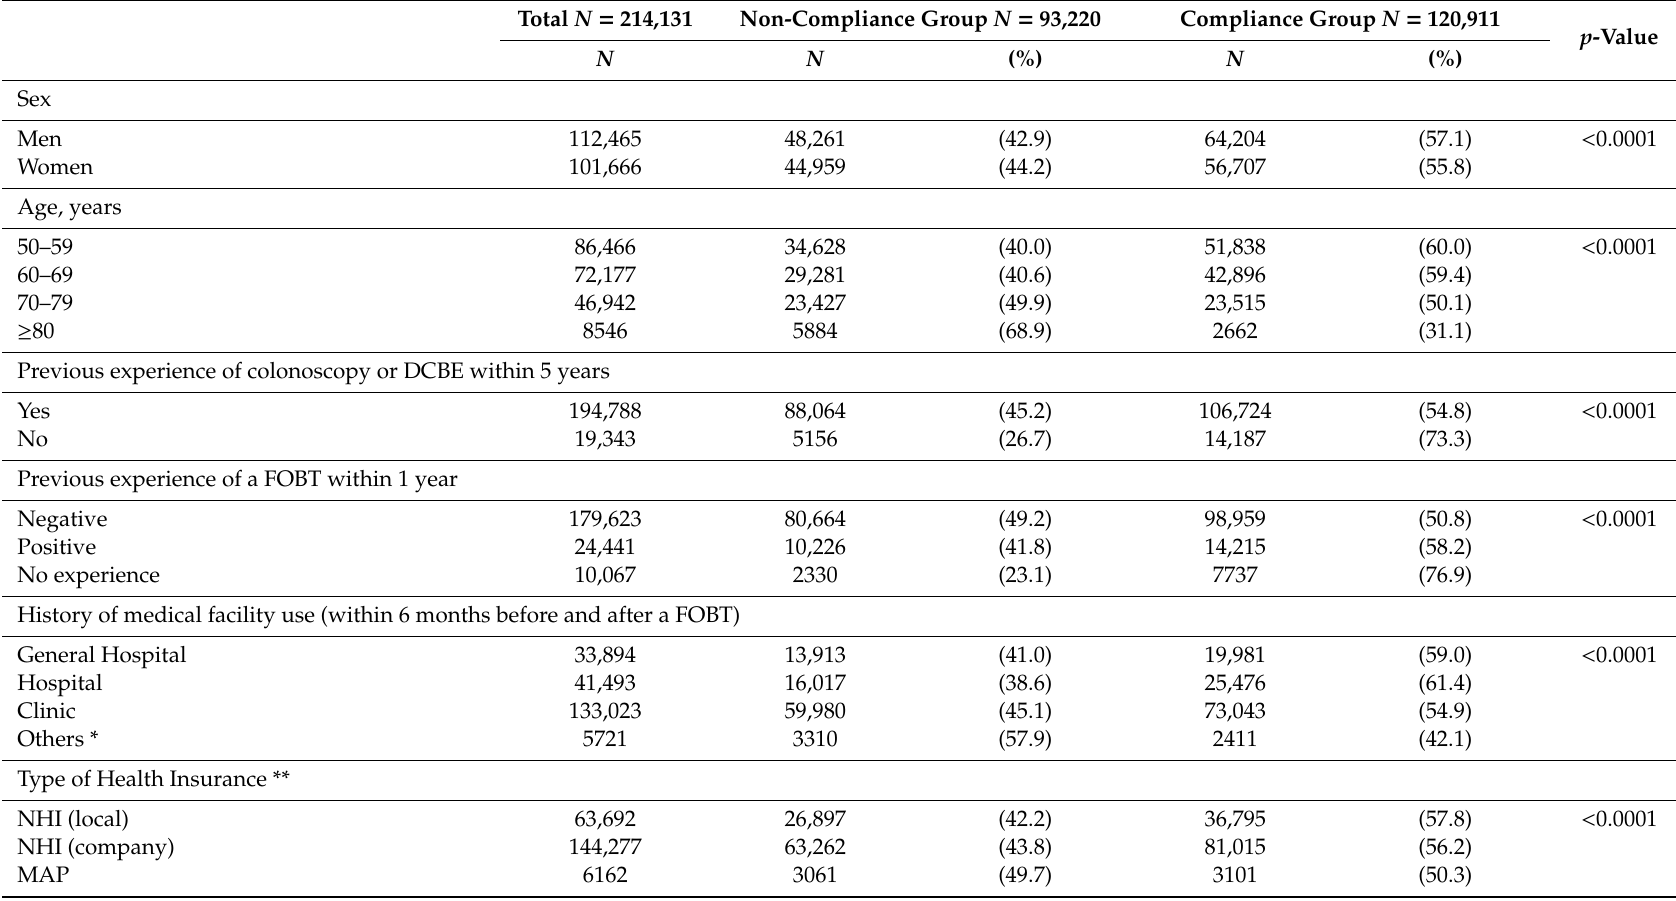
Table 1. Baseline characteristics of individuals according to the compliance to the follow-up test after a positive FOBT in